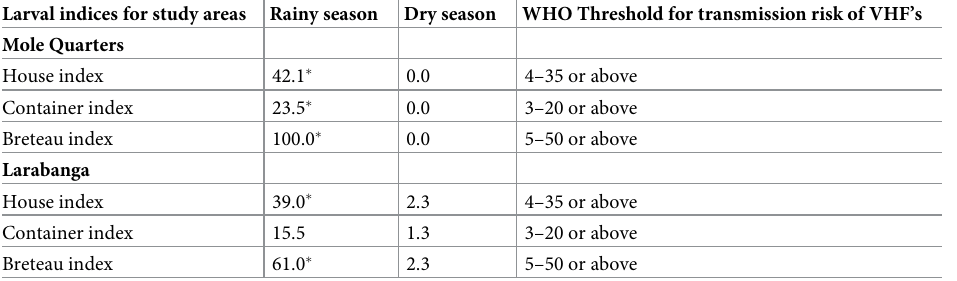
Table 2. Aedes mosquito larval indices and WHO threshold for transmission risk of Aedes -borne viral diseases in Mole Game Reserve and